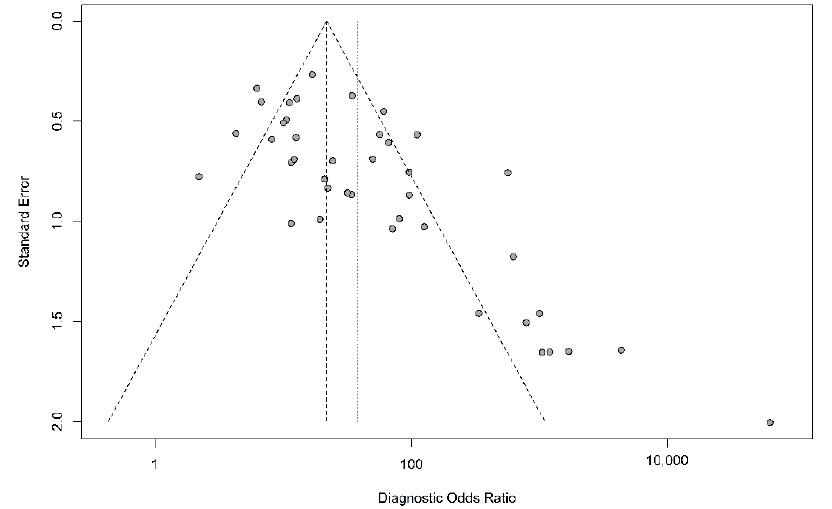
Figure 4. Funnel plot of the diagnostic odds ratio. A skewed asymmetrical funnel plot shows that there is publication bias. In the right lower corner, the small sample size studies (therefore large standard error) are more prone to publication bias than large studies.